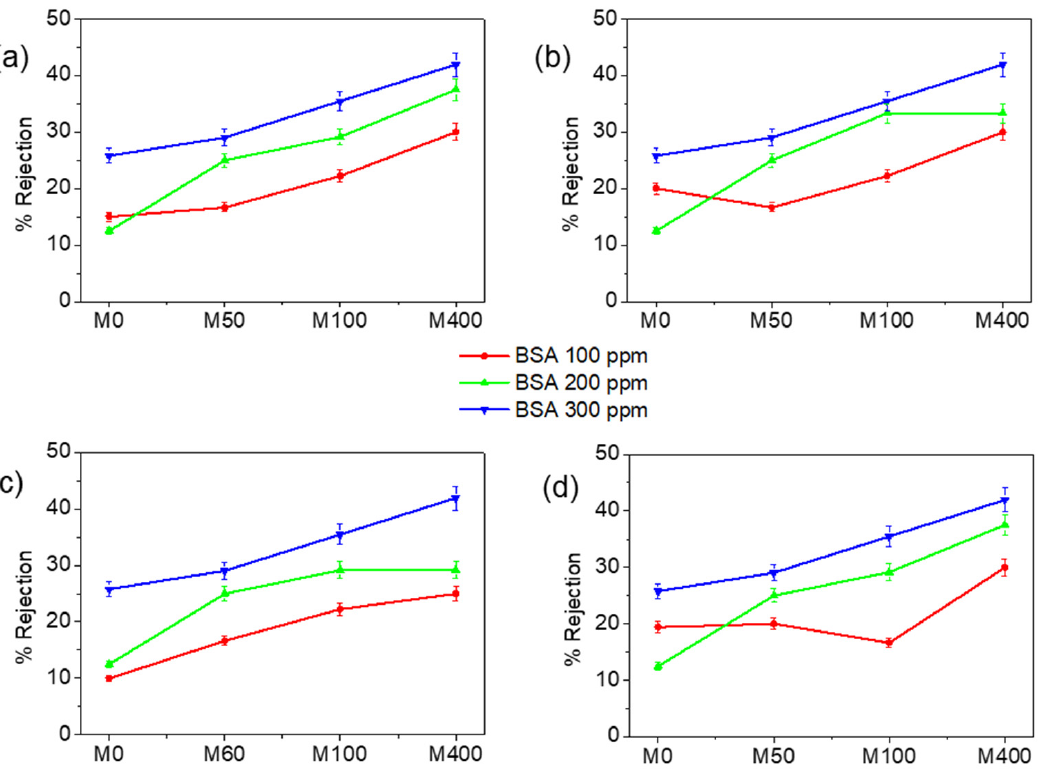
Figure 7. Rejection of nanocomposite membranes of ( a ) 0.05 ( b ) 0.06, ( c ) 0.07, and ( d ) 0.08 mm thickness in a dead-end filtration system at 2 bar pressure.